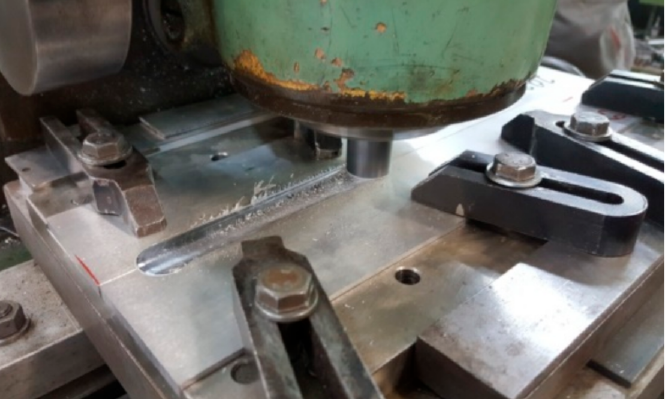
Figure 1. Conventional Milling Machine for friction stir welding